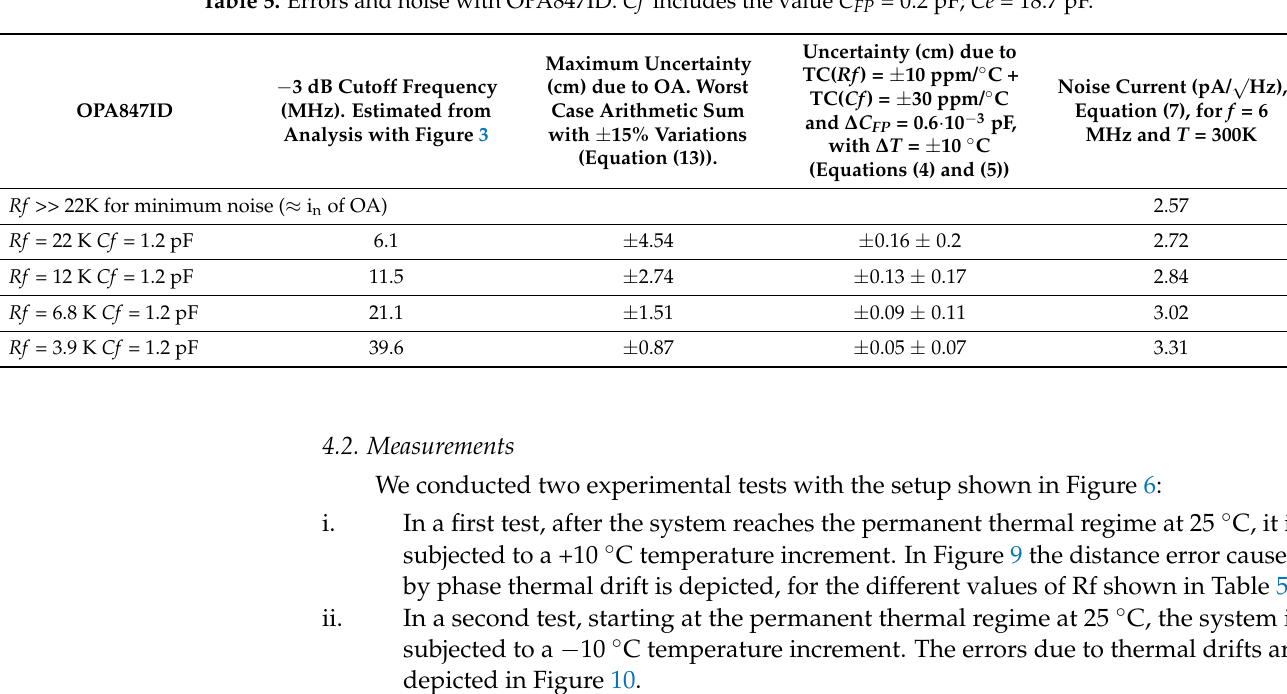
Table 5. Errors and noise with OPA847ID. Cf includes the value C FP = 0.2 pF; Ce = 18.7 pF.